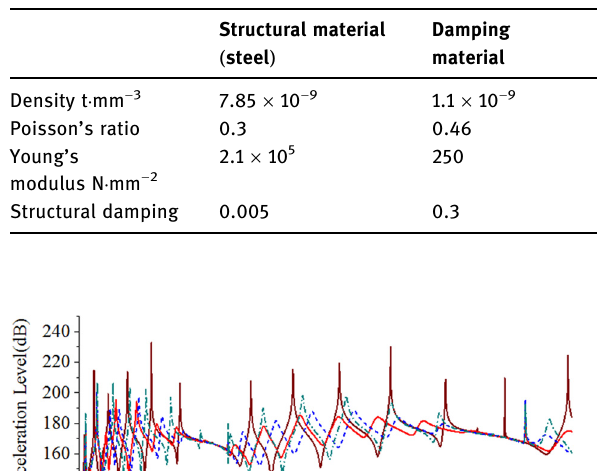
Table 1: Material parameter table